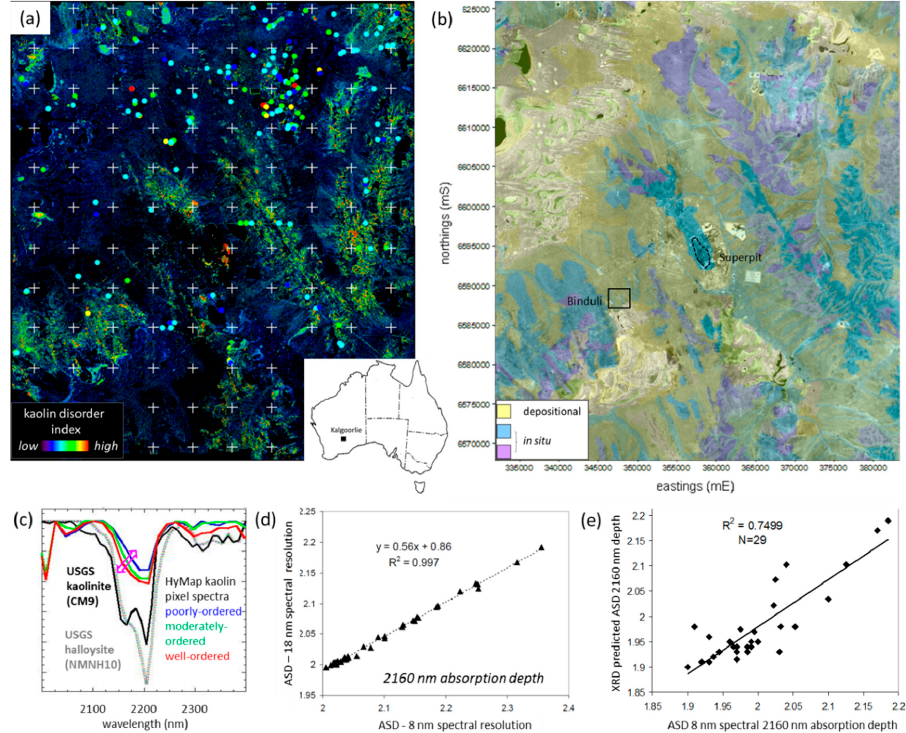
Figure 9. Regolith mineralogy of the Kalgoorlie region, Western Australia, spanning a 2500 km 2 area (26 airborne flight-lines @ 5 m pixel resolution) centered over Kalgoorlie city [100]. ( a ) Airborne HyMap™ (~2005) image of kaolin disorder based on the relative continuum-depths of the 2160 nm and 2200 nm absorption (well-ordered kaolin is a warmer color) masked to include only those pixels that show these kaolin features together with similarly processed field sample spectral data (colored dots); ( b ) Published regolith map showing only depositional (transported) versus in situ units together with the locations of the Superpit (Figure 6) and Binduli (Figure 10); ( c ) Selected airborne HyMap™ pixel and the United States Geological Survey (USGS) mineral library spectra of samples rich in kaolin of different disorder (crystallinity); ( d ) Scatter-gram of ASD spectra of kaolin-rich field samples comparing the depth of the 2160 nm depth measured at 8 nm versus at 18 nm spectral resolution; ( e ) Field sample data comparing the continuum-depth of the 2160 nm absorption versus laboratory XRD data processed using Partial Least Squares (PLS) to predict this same spectral